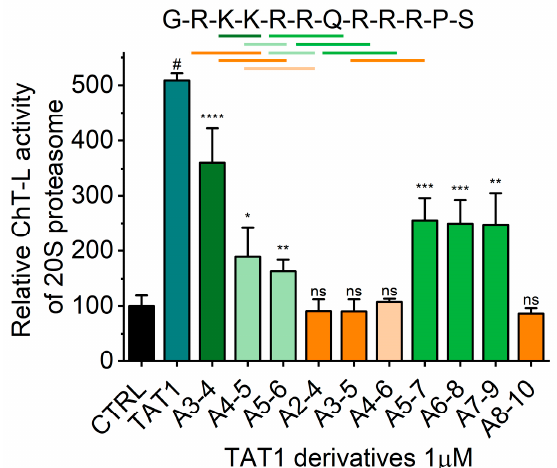
Figure 2. TAT1 derived peptides (1 µ M) with selected residues replaced by alanine were tested for their activating capabilities of the chymotrypsin-like (ChT-L) activity of human latent 20S proteasome. Activity of 20S proteasome in the absence of any TAT peptide (DMSO) was set at 100%. Mean and SD of three independent experiments are presented. Top: The amino acid sequence of TAT1 peptide (1). Bars mark residues replaced by alanine. Green-like colors indicate no significant e ff ect of the substitution, whereas orange-like colors mark hot spots resulting in loss of activation e ff ect. Substitution of any single residue with alanine did not have a noticeable systematic e ff ect on ChT-L activity. Columns show average + SD; *, p < 0.05; **, p < 0.005; ***, p < 0.0005; ****, p < 0.0001; #, p < 1 × 10 − 7 ; ns: not significant; n = 3–5, t-test performed against the activity of control, untreated 20S proteasome.